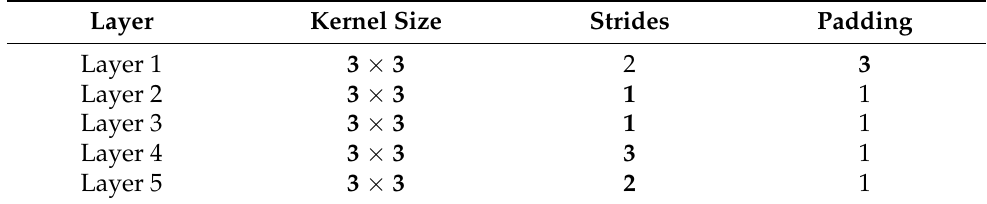
Table 1. Key parameters of the five-layer discriminators used in the present work. Changes from the usual values used in previous work are shown without highlighting, whereas our task-specific alterations are shown using bold